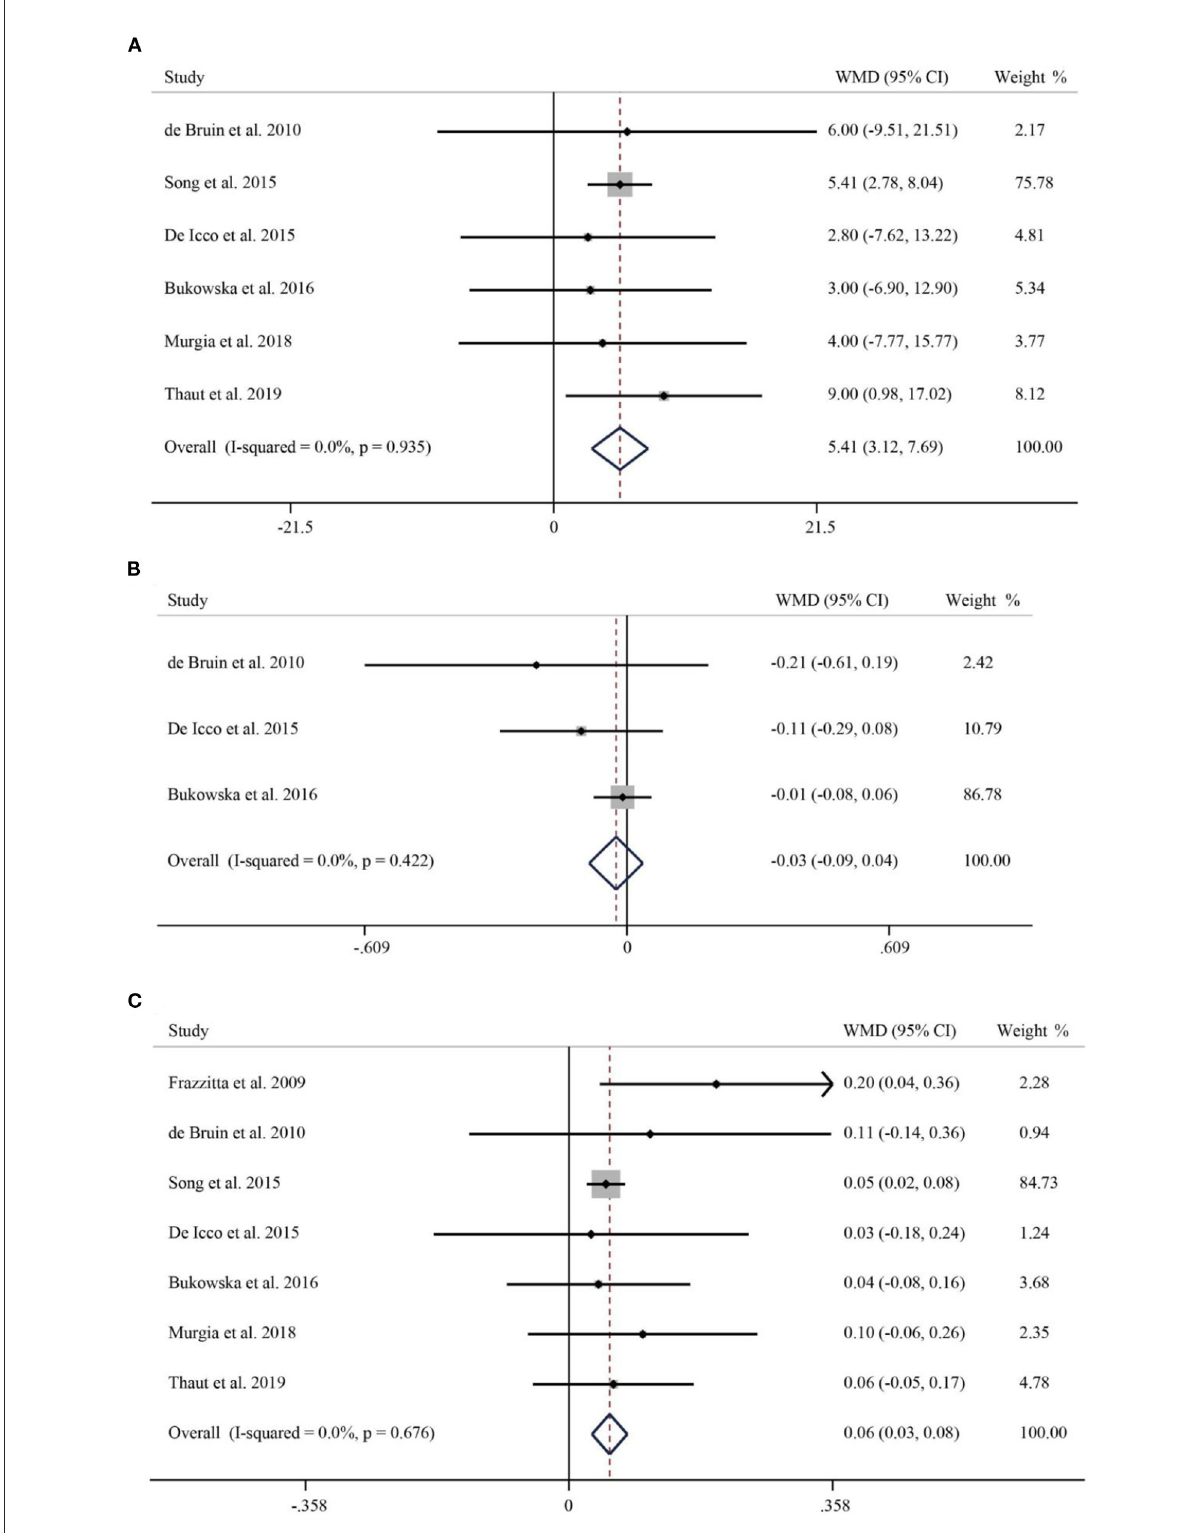
FIGURE2 Forest plot of RAS vs. the control group for stride length (A) , stride duration (B) , and speed (C)